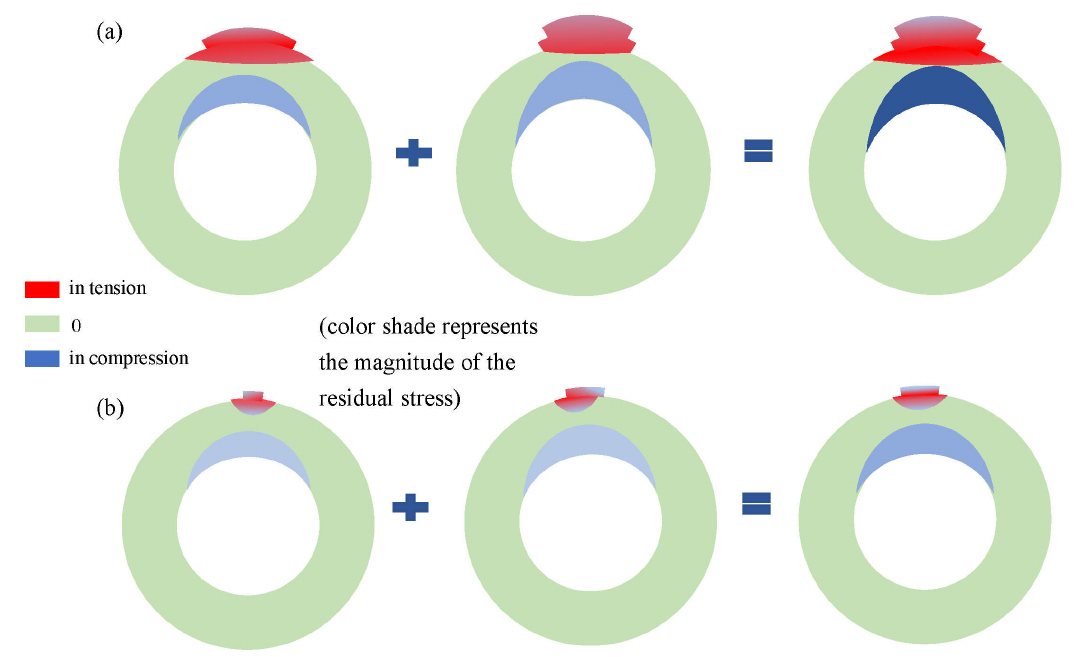
Figure 12. Non-linear superposition function of ( a ) weld passes and ( b ) weld layers.